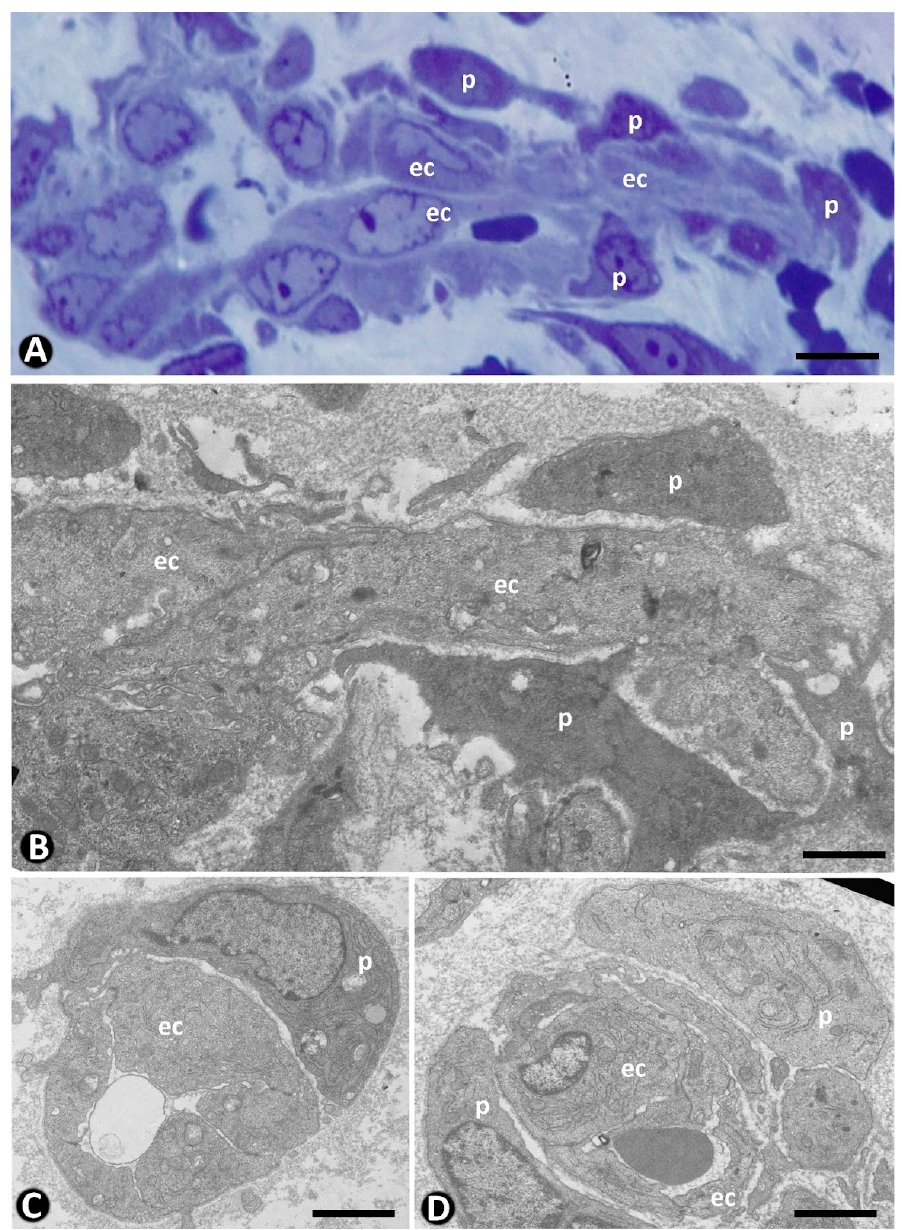
Figure 3. Pericyte recruitment in the vascular sprouts. Pericytes (p) observed around vascular sprouts in semithin ( A ) and ultrathin ( B – D ) sections. In ( B – D ), the ultrastructural images of the vascular sprouts correspond to longitudinal ( B ) and transverse ( C , D ) sections. Endothelial cell: ec. A: Semithin section. Toluidine blue staining. ( B – D ): Ultrathin sections. Uranyl acetate and lead citrate. Bar: ( A ): 10 µ m; ( B ): 0.8 µ m; ( C , D ): 1.5 µ